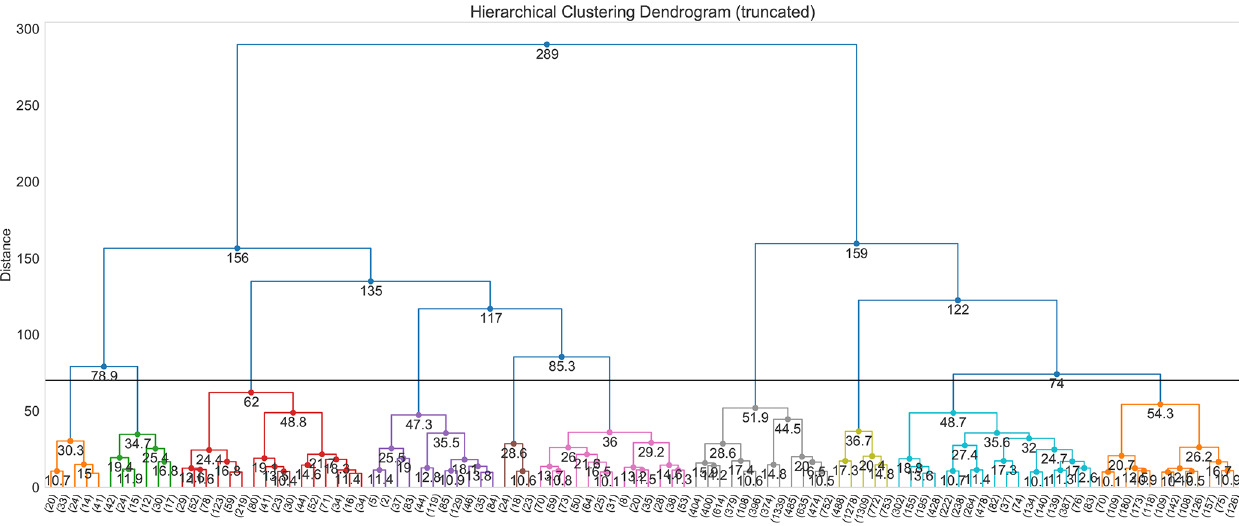
Figure 9. Dendrogram plot of HAC clustering for lower-tropospheric aerosols. Since the number of samples (96 latitude × 192 longitude points, resulting in 18432 samples) is too large to be shown on a single plot, the dendrogram is truncated to display only the path of grouping starting from 100 clusters. The values on the horizontal axis represent the number of samples for each branch of these 100 clusters. The horizontal line marks our selection of the cluster number (i.e. k = 10). The distance ( y axis) measures the Euclidean distance between different clusters. The average distance of the merged clusters is highlighted below the